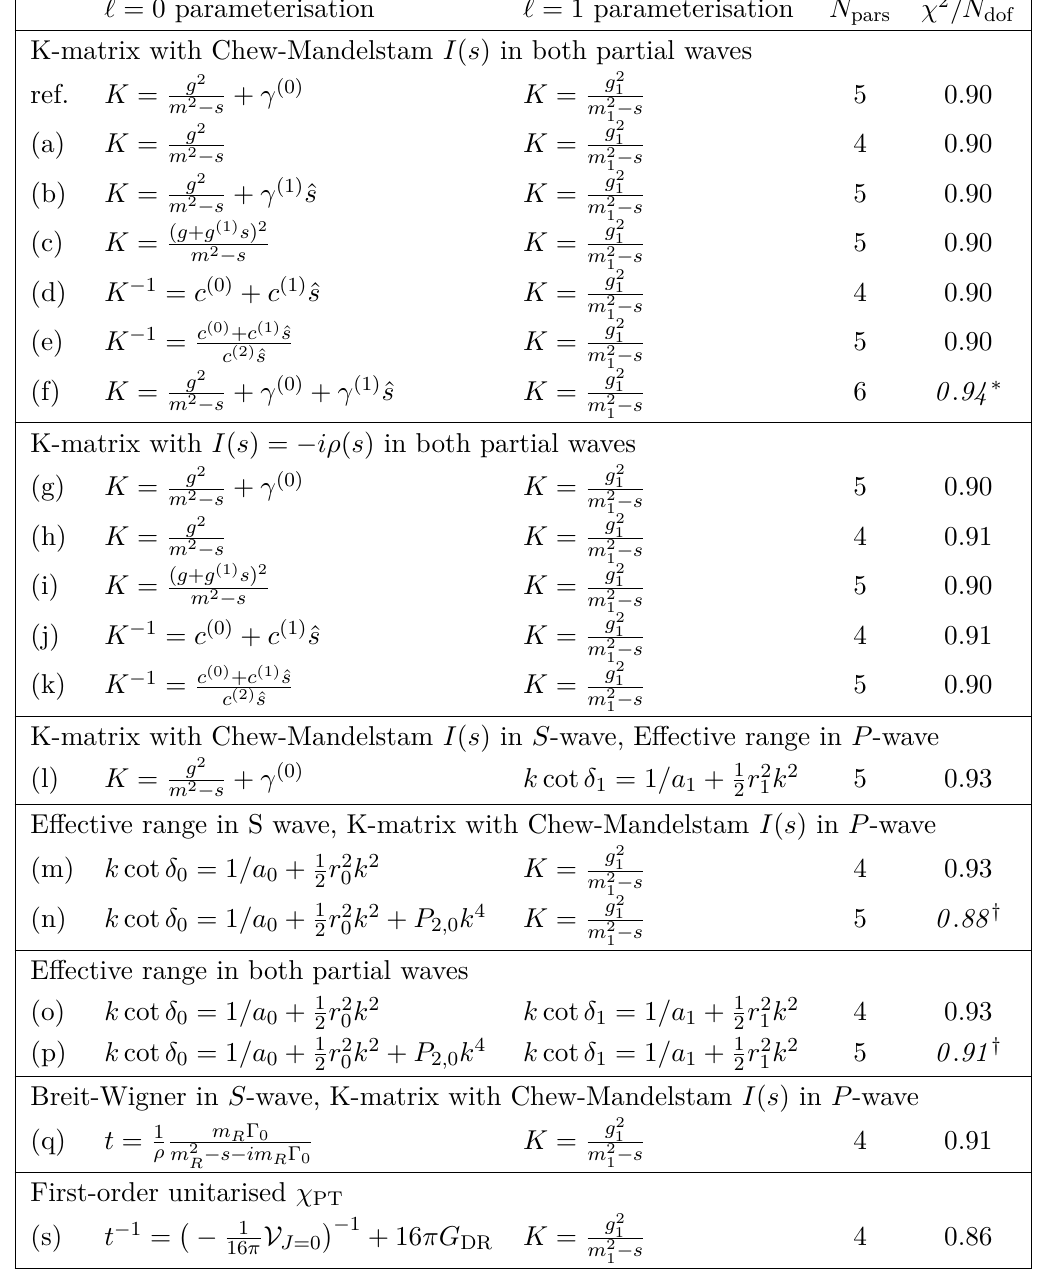
Table 4. The parameterisations used that included the P -wave deeply bound level. N pars indicates the number of free parameters in each parameterisation. An italicised χ 2 /N dof value indicates this fit was not included in the amplitude figure and pole values, due to the presence of either physical sheet poles, or additional resonance poles close to the left-hand